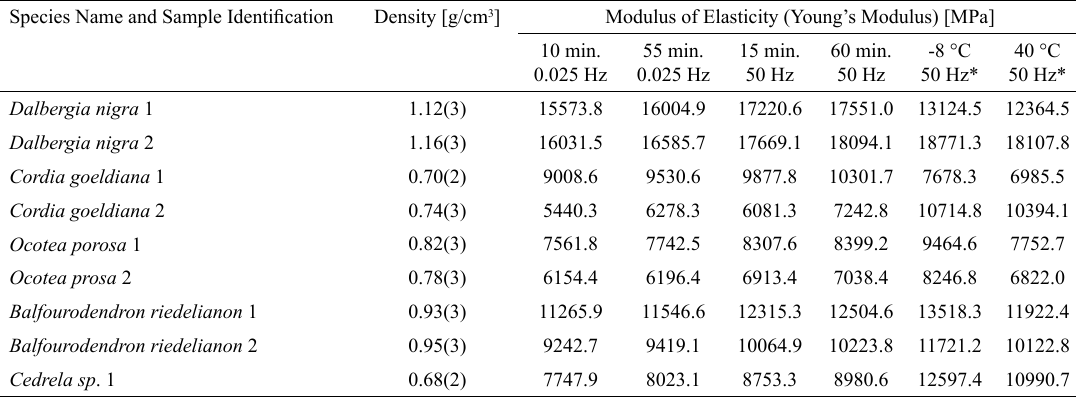
Table 1. Elastic Modulus spectroscopy and variance with temperature